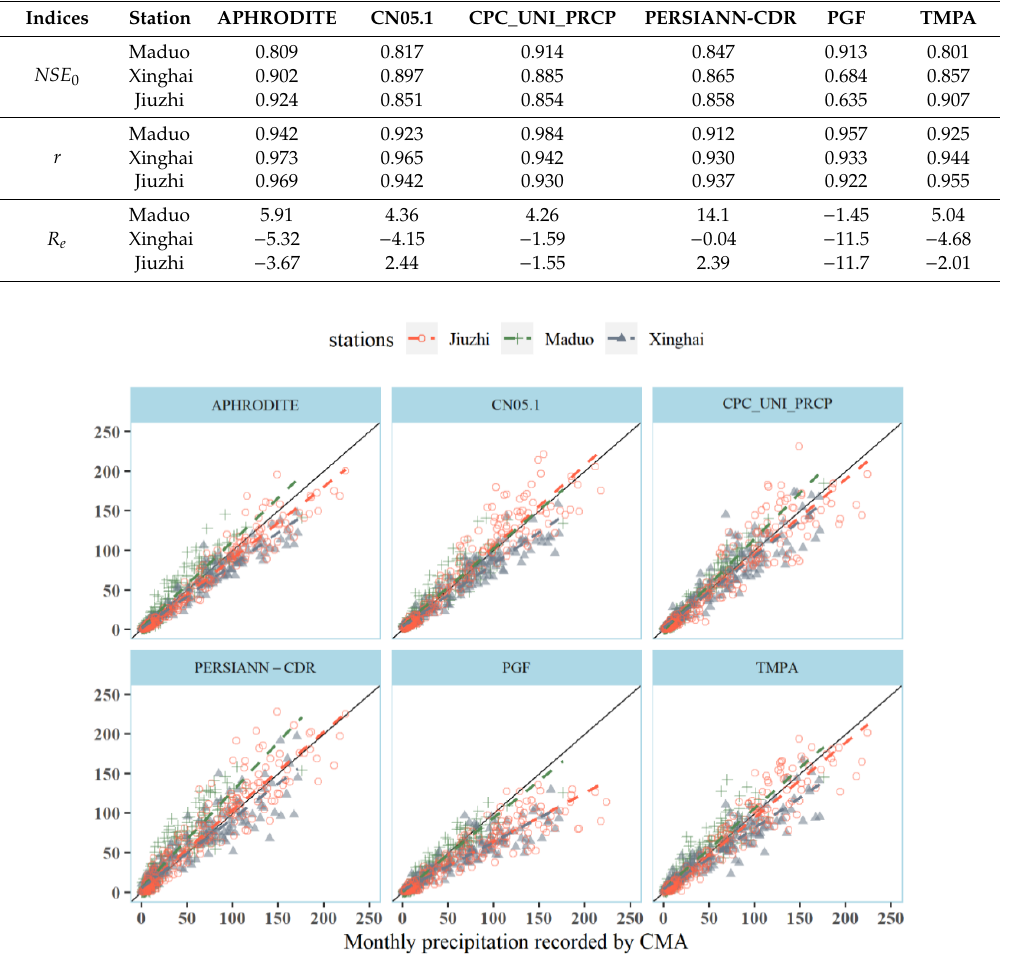
Figure 4. Scatter plot of monthly precipitation (1998–2014) between multiple precipitation products and CMA gauge-based values at three typical gauges in the UYRB.